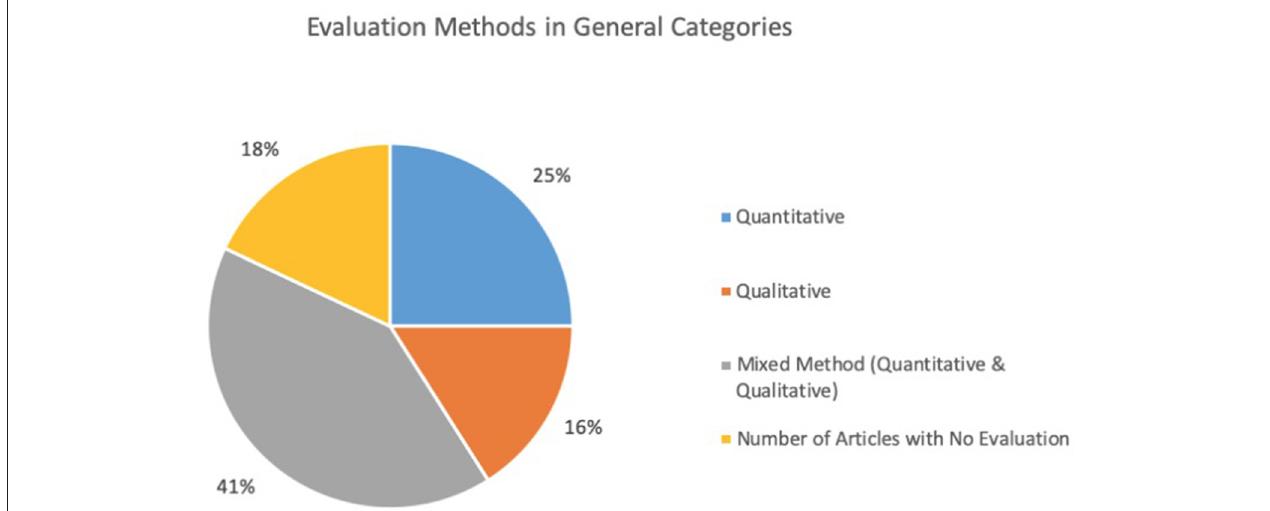
FIGURE 13 | Evaluation methodologies employed by mobile phone-based persuasive technology (PT).